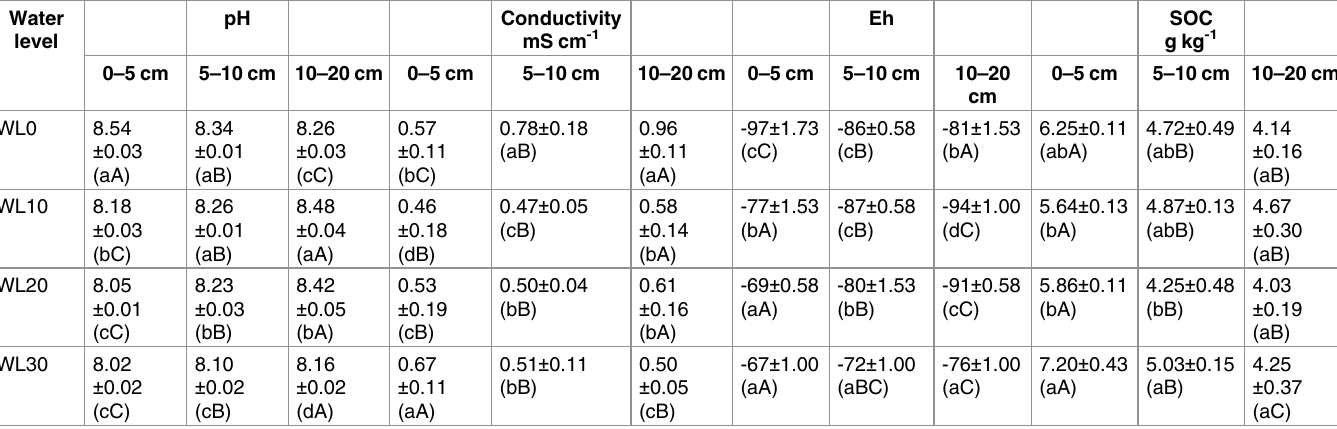
Different lowercase letters in brackets indicate significant differences between water levels within a soil layer ( p < 0.05); different uppercase letters in brackets indicate significant differences between soil layers for the same water level ( p <